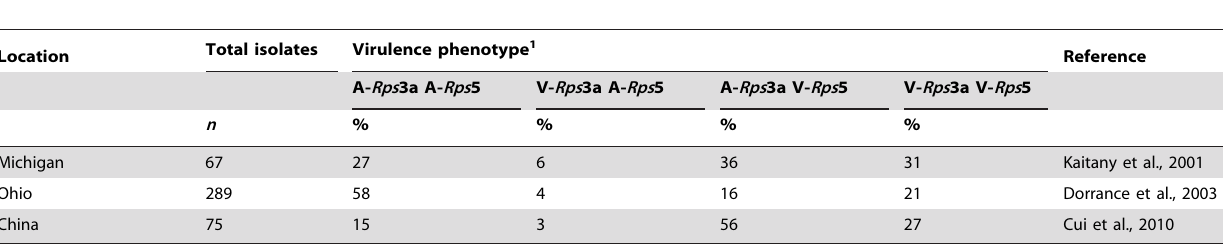
Table 4. Virulence phenotypes in the presence of Rps 3a and Rps 5 of P. sojae field isolates, from three different studies.